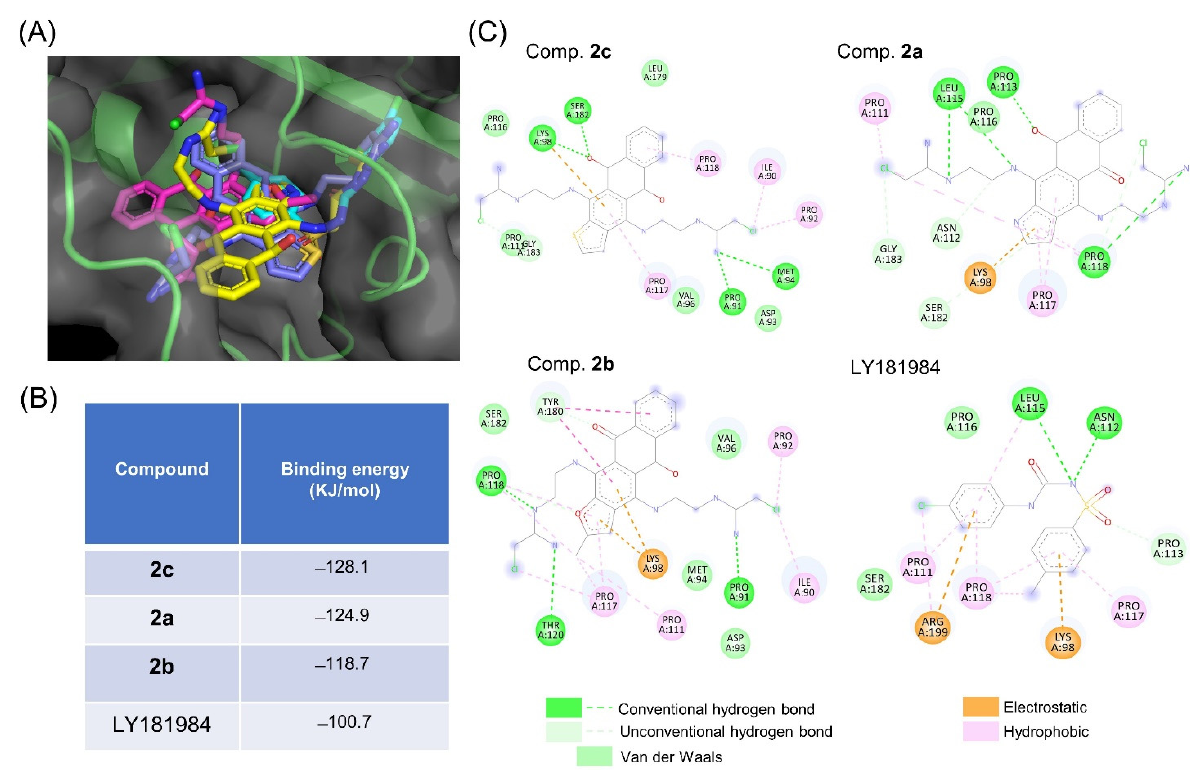
Figure 6. The binding modes of bis(chloroacetamidino)heteroarene-fused anthraquinones 2a – c and LY181984 after docking into the pocket of tNOX. ( A ) Superimposition of the docked derivative 2c (purple), derivative 2a (yellow), derivative 2b (pink), and LY181984 (cyan). ( B ) The binding energy for individual compound. ( C ) Schematic presentations of the putative tNOX binding modes with the studied derivatives 2a – c and LY181984. The key residues surrounding the binding pocket of tNOX were identified through the best docking pose of each compound.